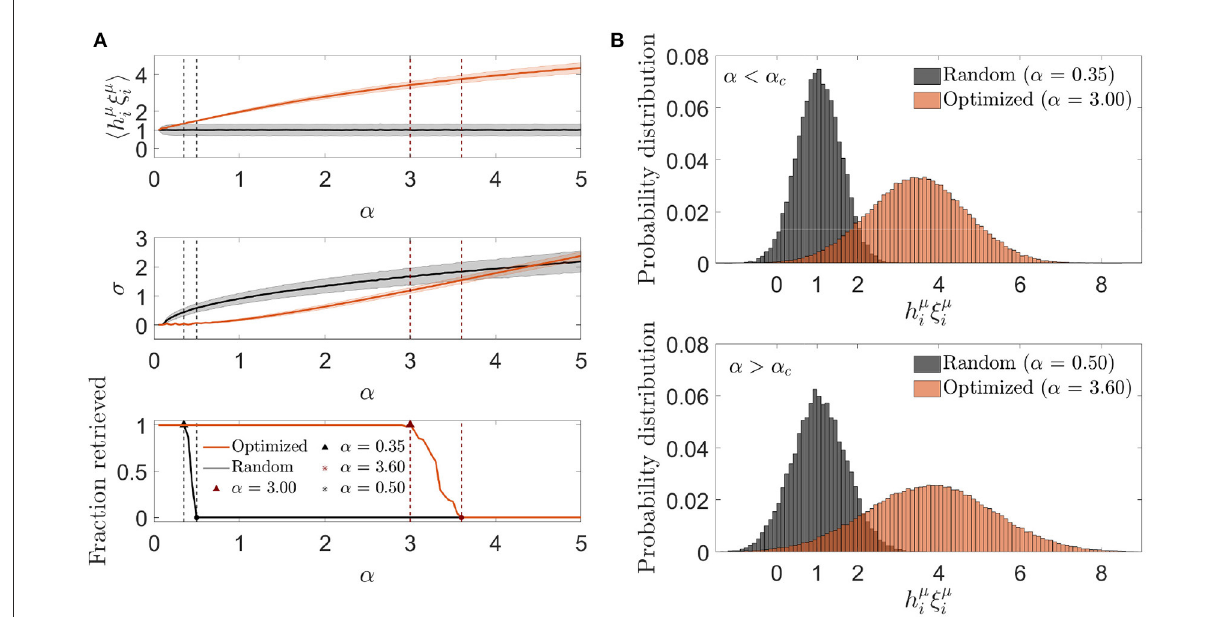
FIGURE8 Optimization by signal reinforcement results from a mean noise increasing faster than its variability. (A) One representative simulation distribution across neurons (of only one trial simulation) of the average (top) and standard deviation (center) of the aligned local field (mean ± s.d.), together with the fraction of retrieved patterns (bottom) as a function of the memory load, for networks with a connectivity that is optimized by signal reinforcement (color) or random (black). (B) Distribution of the aligned local field for specific memory loads slightly lower (top) and higher (bottom) than the storage capacity (indicated in A ) for both kinds of network (same color code). All plots correspond to networks with N = 2,000 and c =